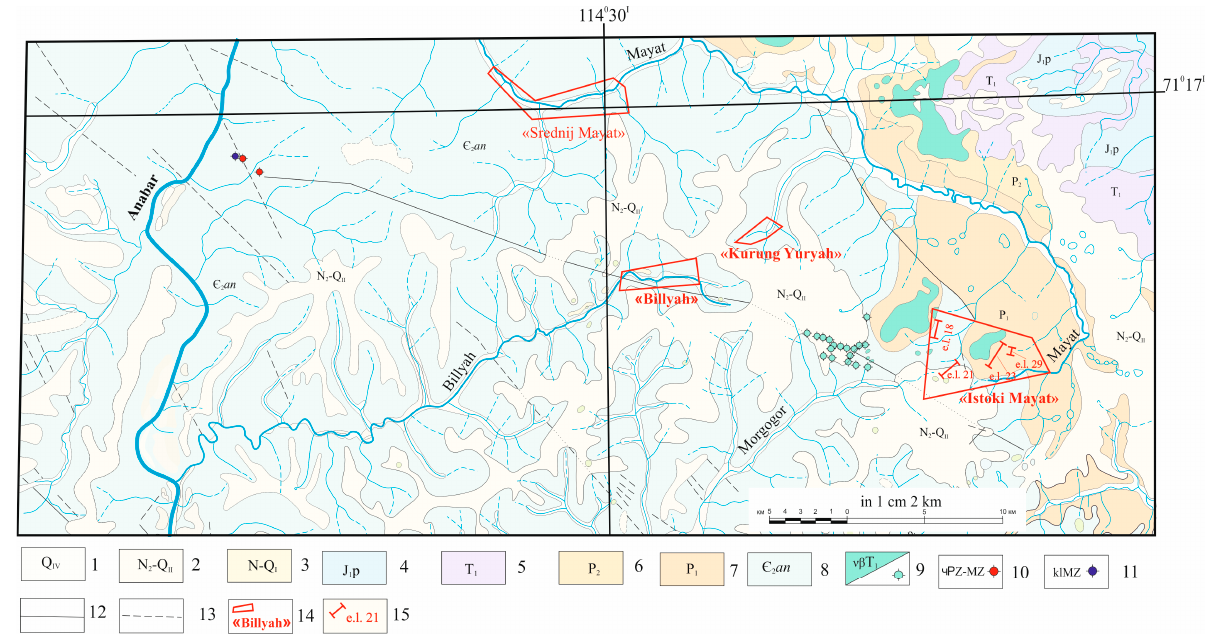
Figure 2. Schematic geological map of the basin of the middle fl ow of the Anabar river [39]: